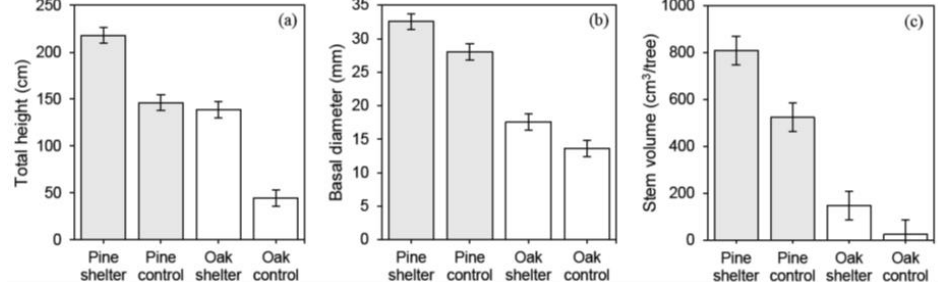
Figure 4. ( a ) Total height ( b ), basal diameter, and ( c ) stem volume of underplanted red oak and white pine in the tree shelter and control treatments (no deer protection) after 6 growing seasons in young forest stands. The interaction effect is not significant for total height ( p = 0.19), basal diameter ( p = 0.81) and stem volume ( p = 0.19). The Species effect is significant at p < 0.001 for all variables. The Deer protection treatment effect is significant at p < 0.001 for total height and at p < 0.01 for basal diameter and stem volume. Pine = white pine and Oak = red oak. Table 1. Tree species effect on survival, height, basal diameter, stem volume of underplanted bitternut hickory and black walnut after 6 growing seasons in young forest stands (all trees protected with shelters). SE = standard error of the mean.